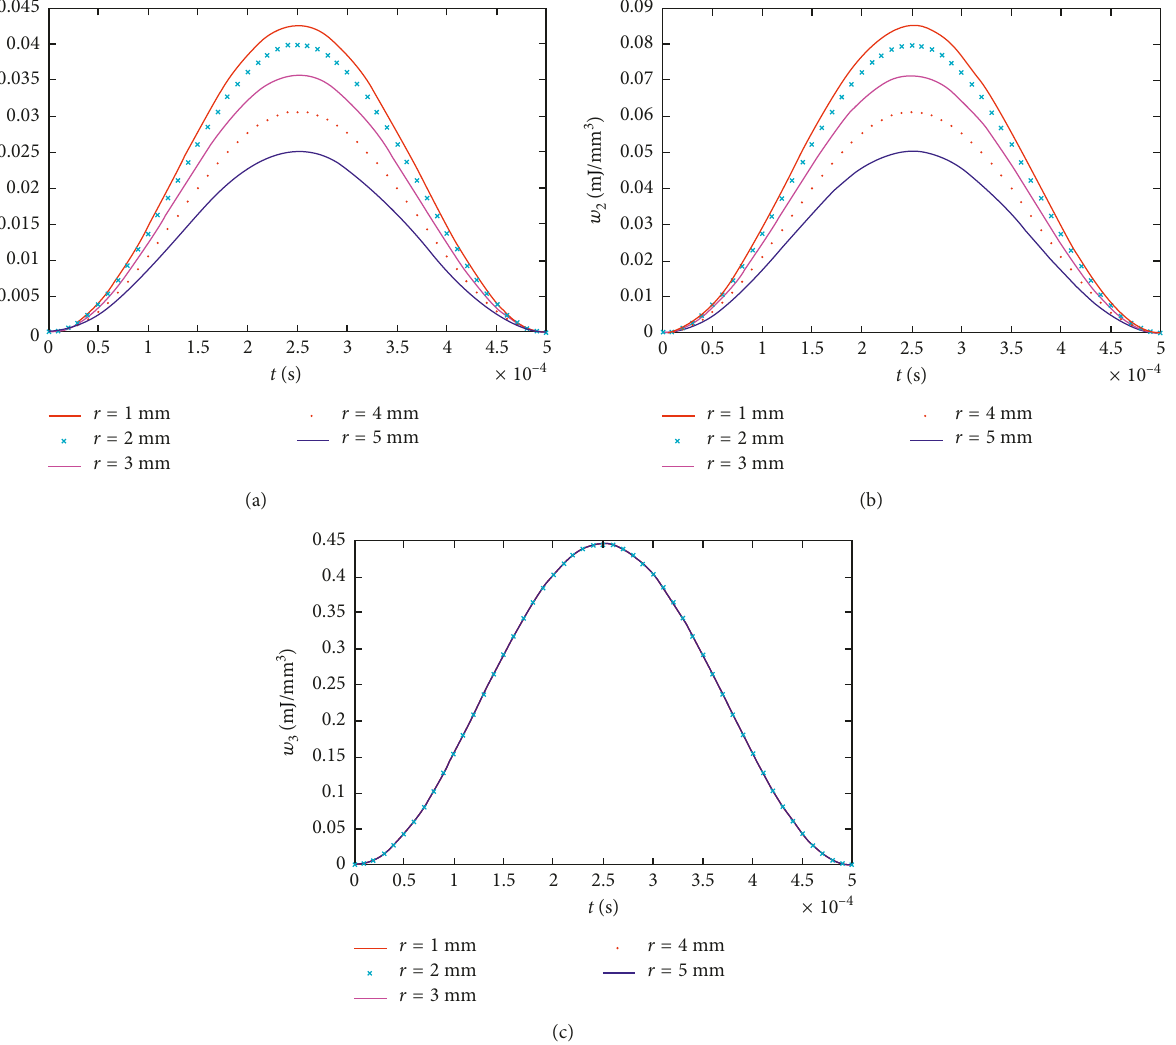
Figure 5: The influence of the radius of the string on the energy density ( α v 1 . (b) The energy density caused by the longitudinal wave u 2 . (c) The energy density caused by the flexural wave v 3 v 0 −